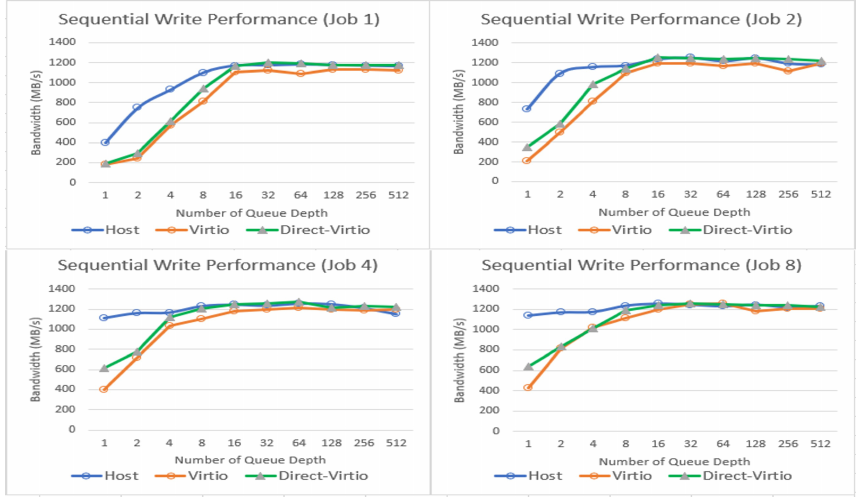
Figure 8. I/O performance comparison between Virtio and Direct-Virtio for sequential write